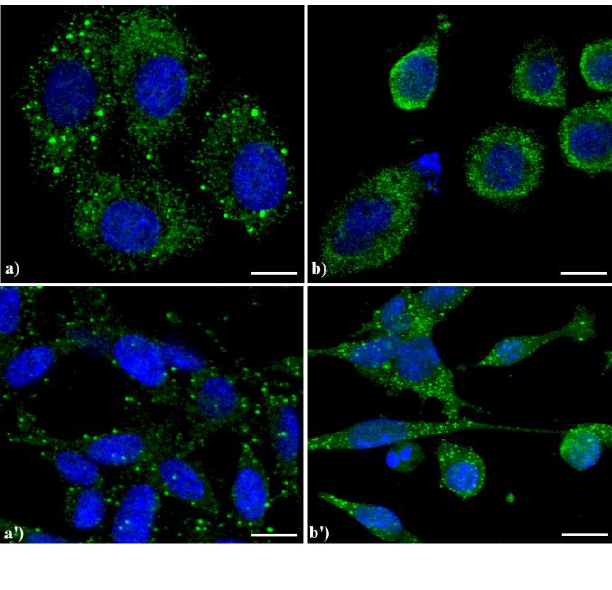
Figure 4. Confocal microscopy of immunolabeling of lysosomes. ( a ) control HeLa cells; ( b ) HeLa cells treated with etoposide (40 μM for 20 h); ( a' ) B50 control cells; ( b' ) B50 cells treated with cysPt (40 μM for 48 h). Cells were fixed and incubated with a human autoimmune serum (1:200 in PBS) recognizing lysosomal proteins (a kind gift of Dr. Claudia Alpini, IRCCS San Matteo, Pavia, Italy [20]) revealed with Alexa 488-conjugated anti-human IgG (1:200 in PBS, green fluorescence; Molecular Probes). DNA was counterstained with Hoechst 33258 (blue fluorescence). Scale bar: 20